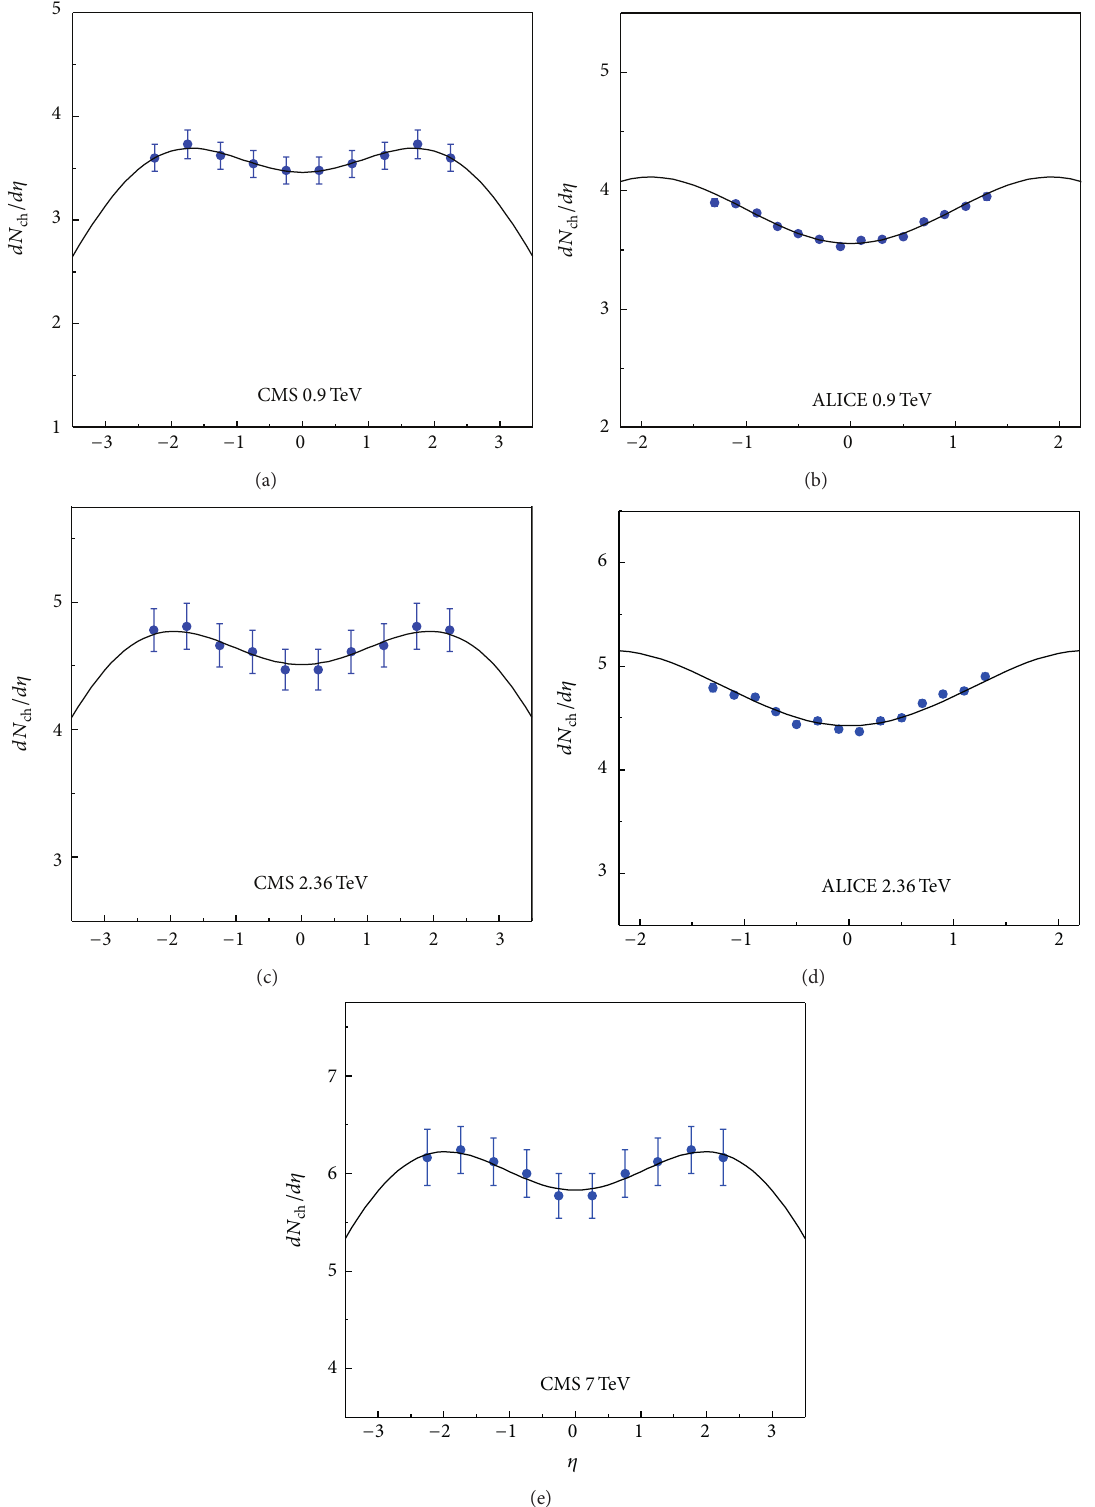
Figure 3: The pseudorapidity distributions of charged particles in non-single-diffractive 𝑝 - 𝑝 collisions at √ 𝑠 𝑁𝑁 = 0.9 (a, b), 2.36 (c, d), and 7 TeV (e). The symbols represent the experimental data of the CMS [24, 25] (a, c, e) and ALICE Collaborations [23] (b, d), and the curves are our calculated